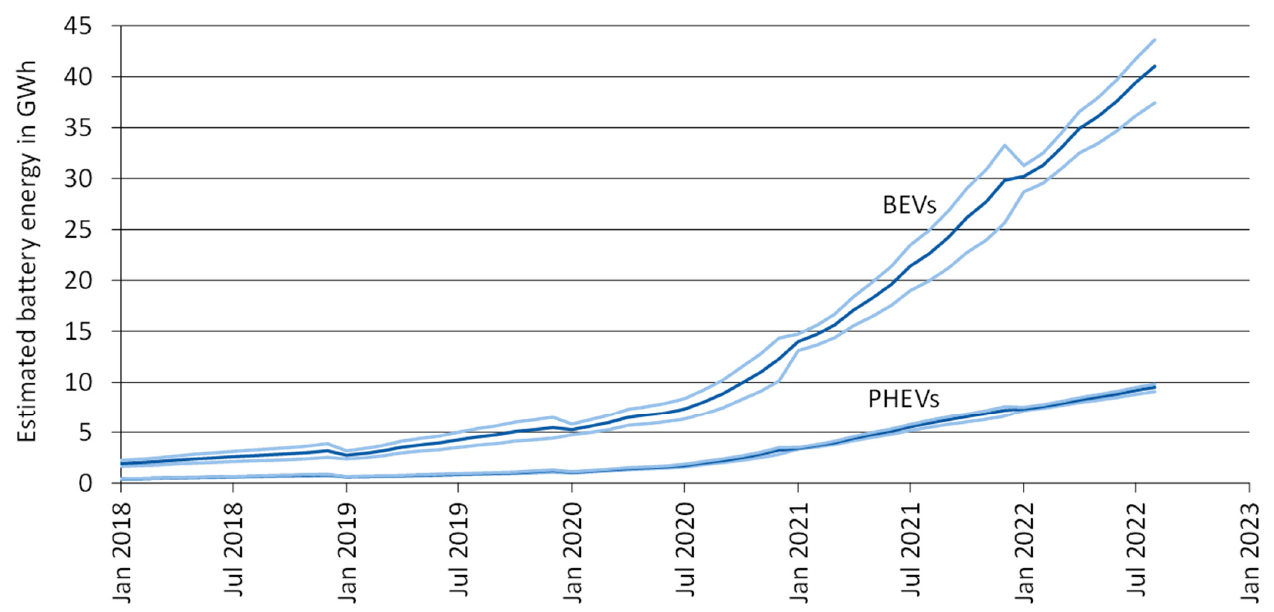
Figure 2. Estimated battery energy of the EV fleet over time split by BEVs and PHEVs. The dark-blue line is the estimated central value. The surrounding light-blue lines are the error corridor that results from the fact that the national car registry’s identification system does not differentiate between the battery energy difference of different versions of a car model.